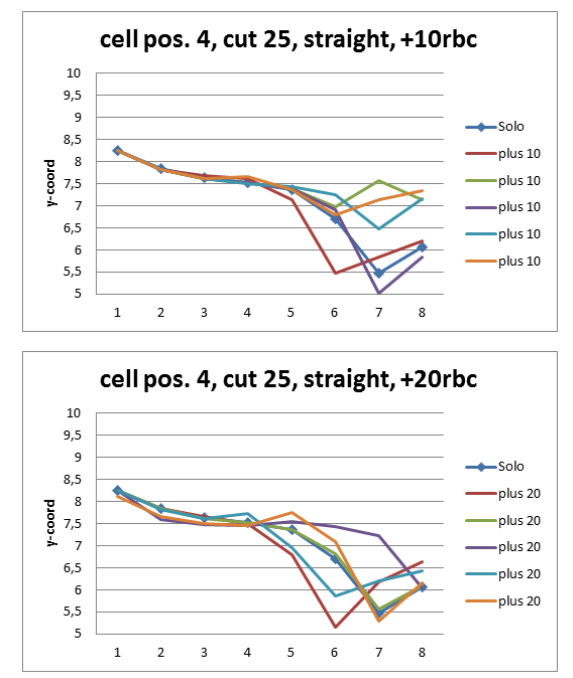
Fig.7. For cutting position 25 + k.100 μm and cell with starting position 4 (20 μm from edge), straight orientation, the differences after adding 10 and 20 cells are not so distinct